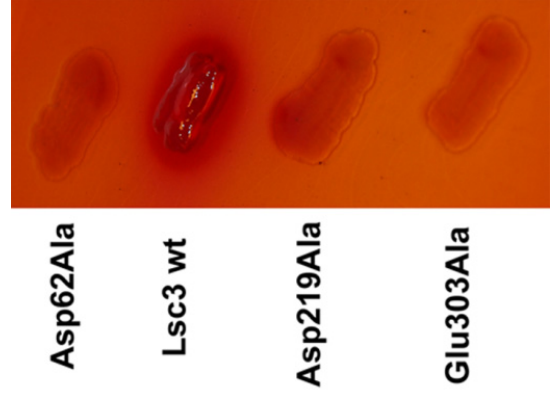
Figure 3. Levan synthesis phenotype of E. coli BL21(DE3) expressing wild-type Lsc3 and alanine replacement mutants of the catalytic triad amino acids. Transformants were streaked onto MacConkey + Amp medium containing 10% sucrose and 1 mM IPTG to induce the T7 polymerase and grown at 37 °C (see Section